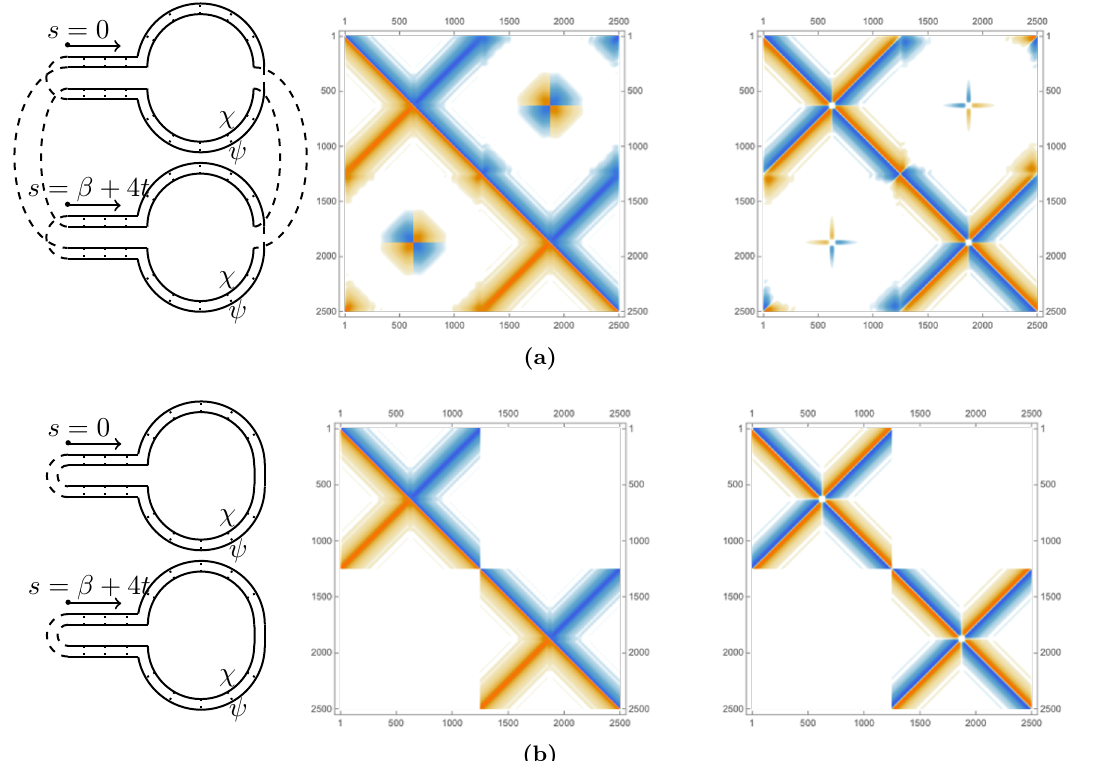
Figure 5. (a) The long-time solution with t = 6 (cid:12); V 2 =J = 0 : 05. The two matrix plots are the real part and the imaginary part respectively (same in (b)). (b) The trivial solution that we do not insert any twist